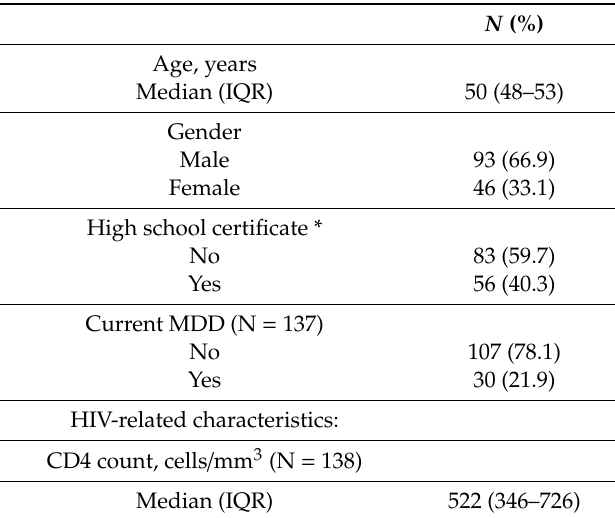
Table 1. Characteristics of HIV-HCV coinfected patients in the study population, the ANRS